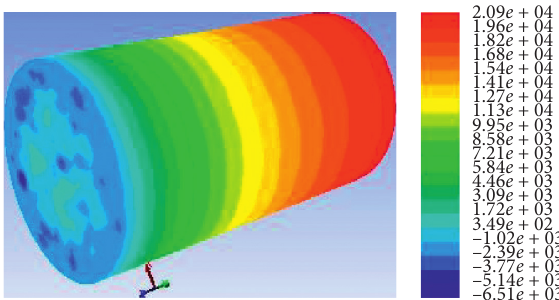
Figure 14: Pressure cloud diagram of the flame